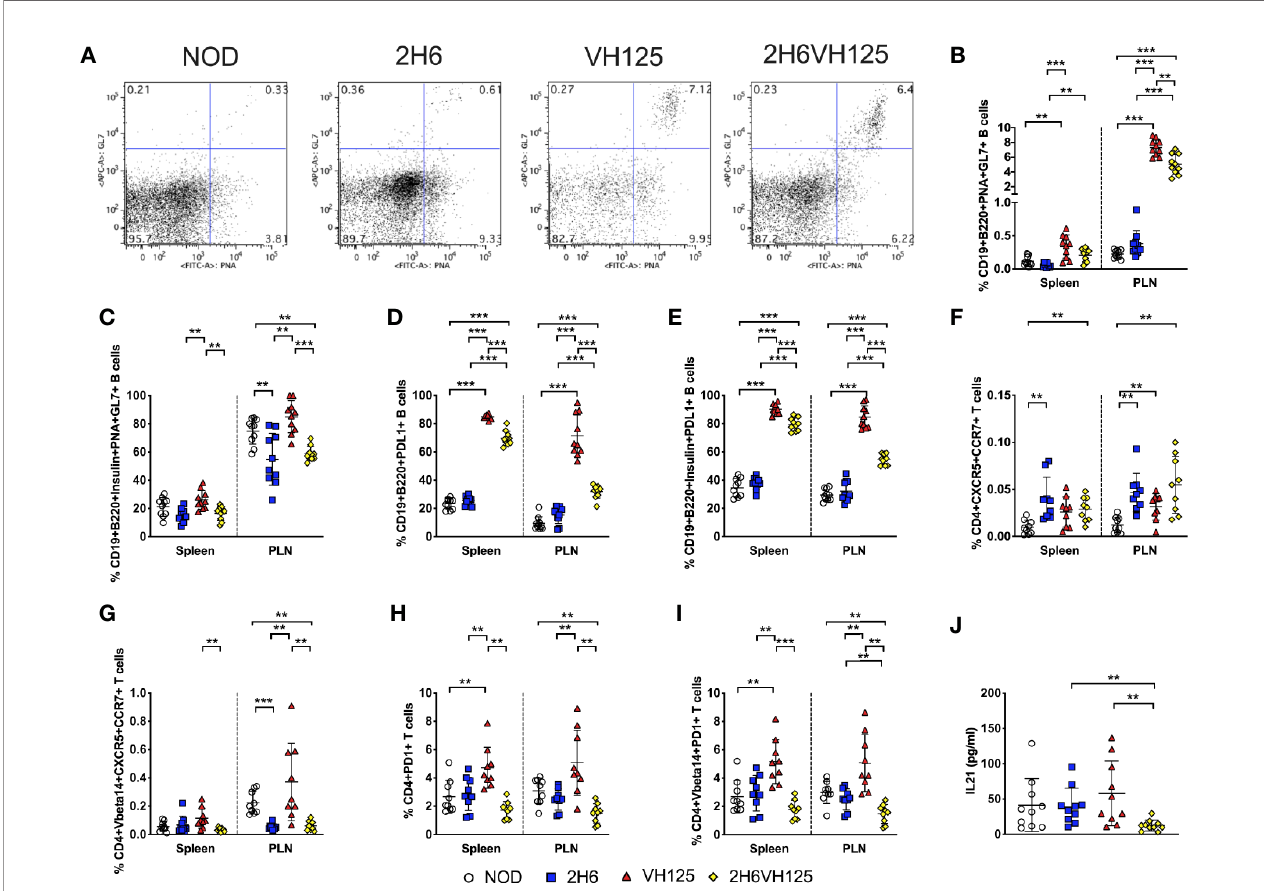
FIGURE 5 | 2H6 TCR transgene alters germinal center interactions in vivo. Splenocytes and cells from the pancreas draining lymph nodes (PLN) were harvested from 8-week-old mice and stained using antibodies for fl ow cytometry. (A) Representative fl ow plots showing PNA vs. GL7 staining of CD19+B220+ B cells, gated from live singleTCR b - cells with summary (B) . (C) Insulin-reactive germinal center B cells % [gatedas (B) on Insulin+CD19+B220+ B cells]. (D) % CD19+B220+PDL1+ B cells gated as in (B) and insulin-reactive CD19+B220+PDL1+ B cells (E) . (F, G) % oflive singleCD4+CD8-CD19-CXCR5+CCR7+ T cells gated on total CD4+ T cells (F) and TCRVbeta14+ CD4+ T cells (G) . (H,I) % of live singleCD4+CD8-CD19-PD1+ T cells gated on total CD4+ T cells (H) and TCRVbeta14+ CD4+ T cells (I) . IL21 was measured insera from 8-week-old mice byELISA (J) . Data were generated from 9 to 10 individual mice pooled from 4 to 5 independent experiments. Data from leftto right: NOD, 2H6, VH125, and 2H6VH125 are shownin this order in each plot. Data from NODmice are shown as a non-transgenicmouse comparison.Data were assessed for signi fi cance using multipleT tests andFDR correction.**P < 0.001, ***P <